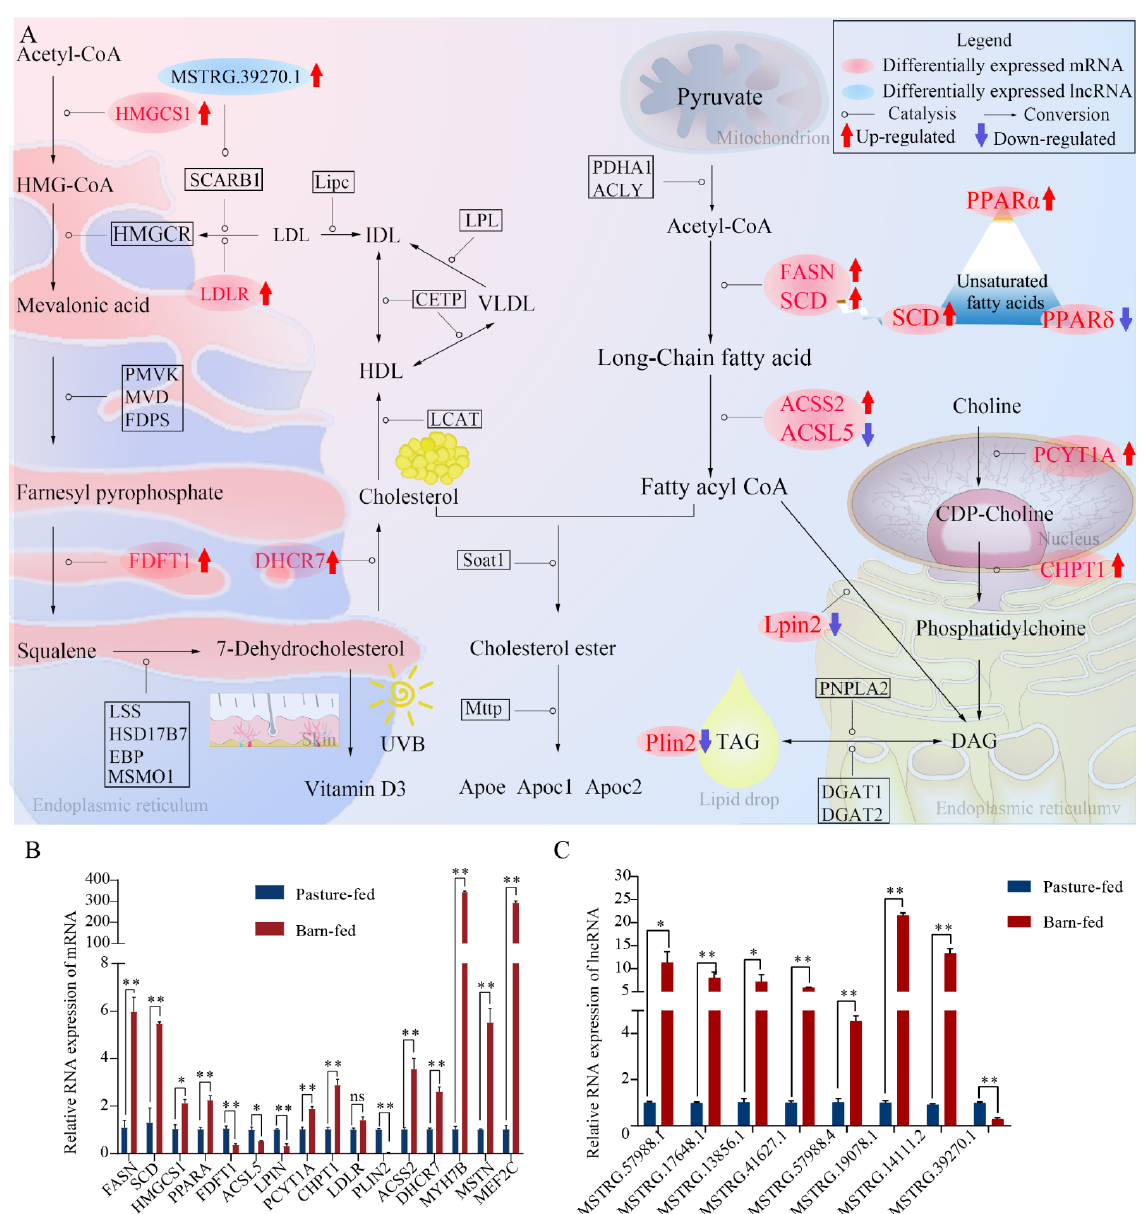
Figure 5. Analysis of the underlying molecular mechanism and qRT-PCR analysis of the differentially expressed genes and lncRNAs. ( A ) Analysis of the underlying molecular mechanism of the two feeding models. Genes and lncRNAs in red or blue indicate the differentially expressed genes or lncRNAs identified in this study; arrows in red or blue indicate up-regulated or down-regulated in the barn-fed group. ( B ) qRT-PCR analysis of the differentially expressed mRNA. ( C ) qRT-PCR analysis of the differentially expressed lncRNA. * and ** indicate significant different ( p < 0.05 or p <